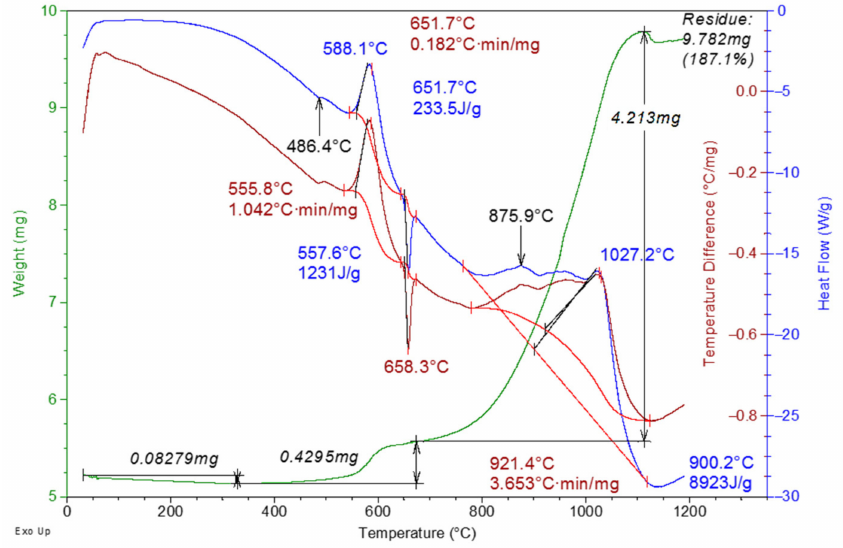
Figure 5. Thermogram of Al micropowder after exposure to microwave with a pulse duration of 25